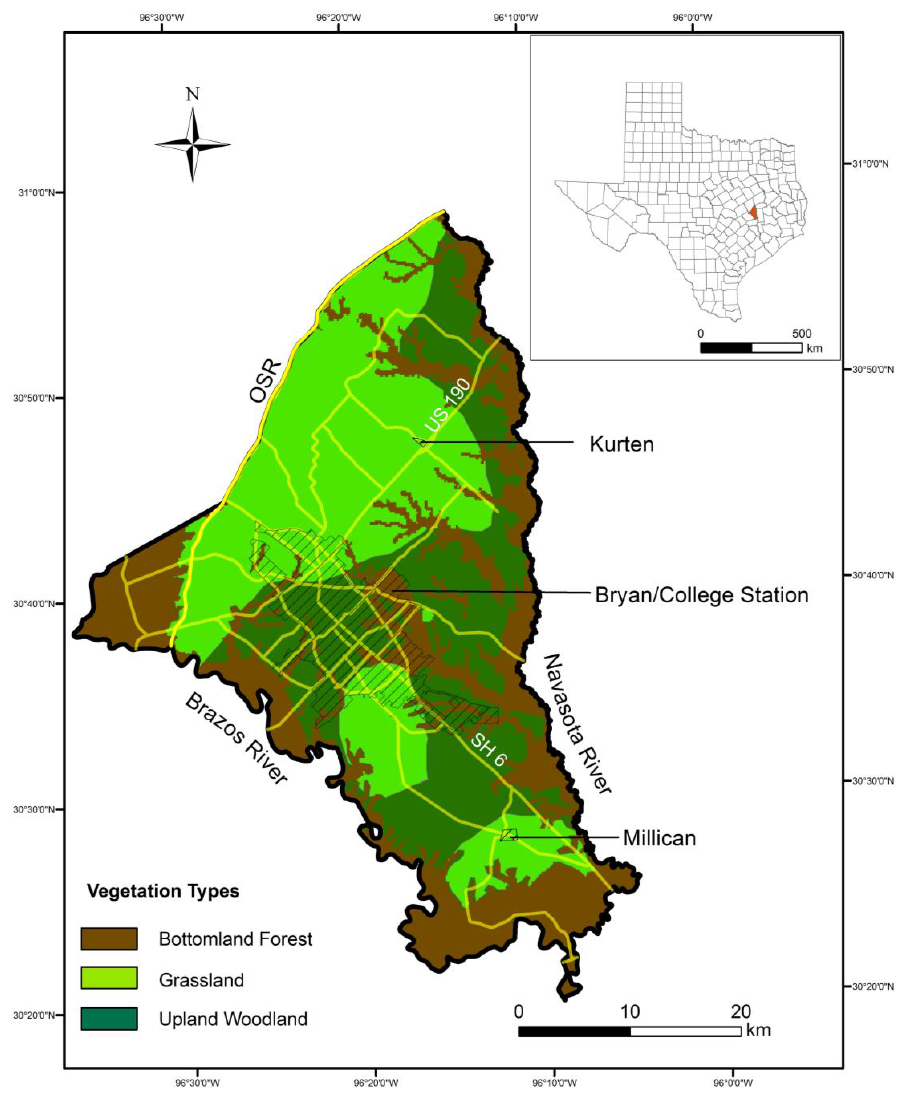
Figure 1. Reconstructed presettlement vegetation cover for Brazos County. The present day major settlements (cross hatched areas) and road network are overlain on the reconstructed vegetation data.